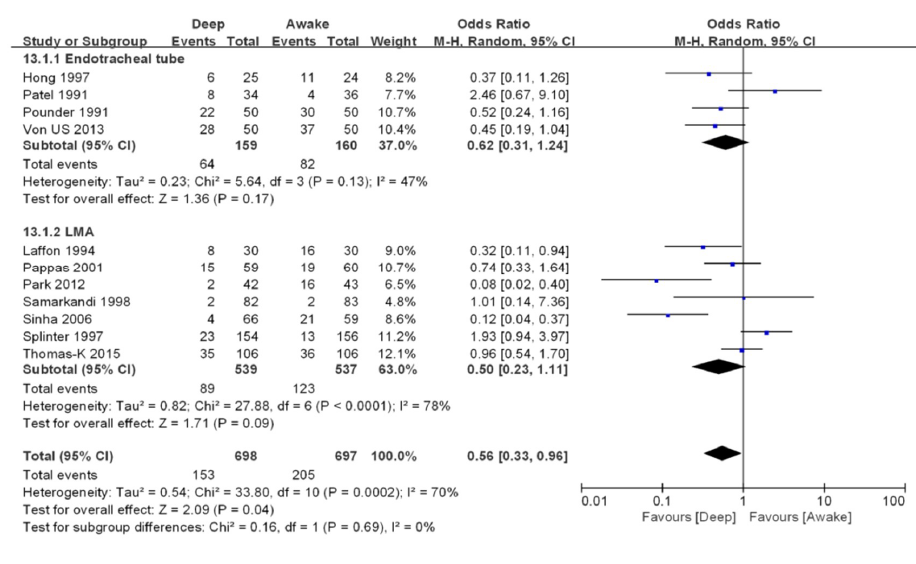
Figure 3. Forest plot of comparison. Deep extubation (experimental) vs. awake extubation (control). Outcome: Overall